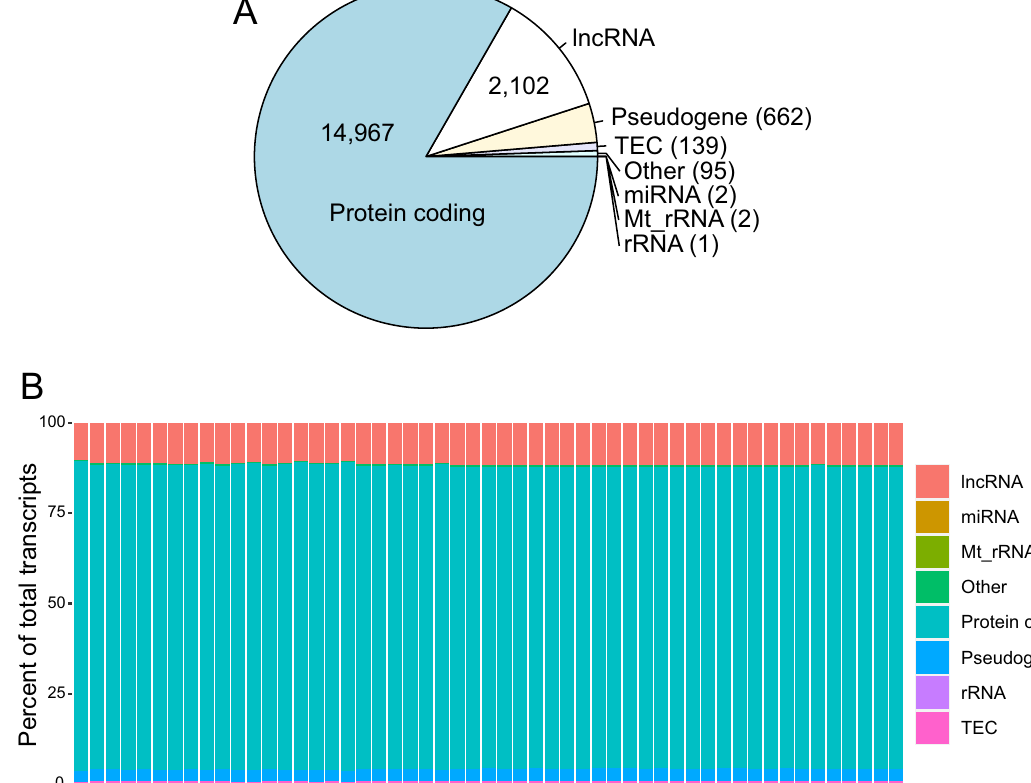
Figure 2. ( A ) Summary of transcript biotypes in the whole transcriptomics dataset. ( B ) Biotypes percentage by sample. lncRNA—long non-coding RNA, miRNA—micro-RNA, Mt_rRNA—mitochondrial ribosomal RNA, rRNA—ribosomal RNA, TEC—to be experimentally